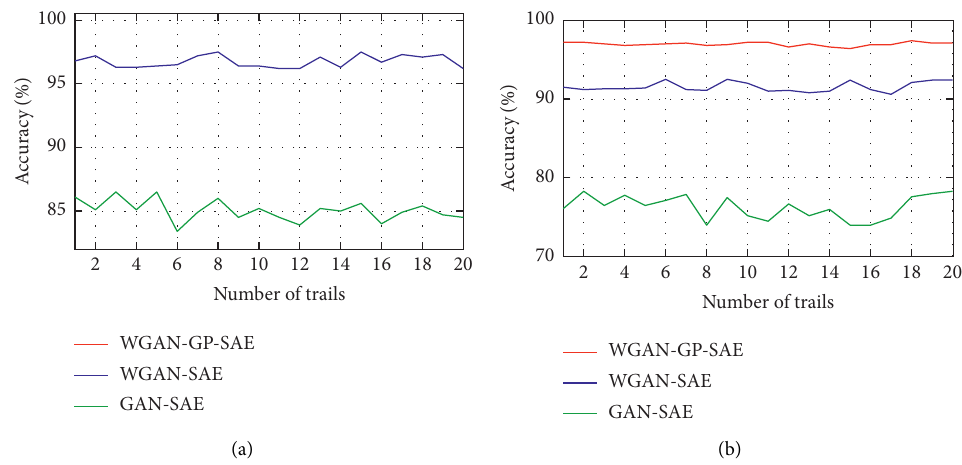
Figure 5: Testing accuracies of the two datasets using the three methods. (a) Dataset A. (b) Dataset B.